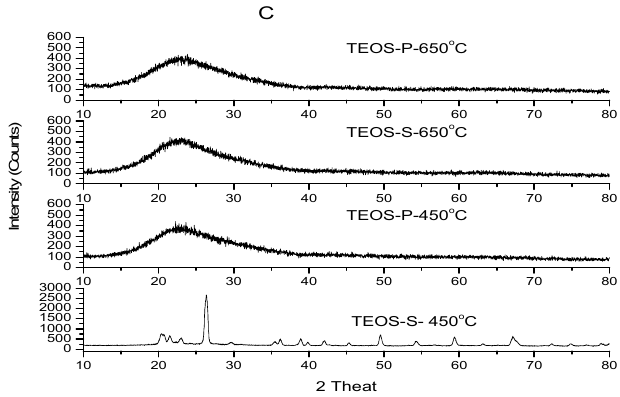
Figure 1. X-ray diffraction patterns of ( A ) SiO 2 and its treatment with sulfuric and phosphoric acid; ( B ) TiO 2 and its treatment with sulfuric and phosphoric acid; and ( C ) SiO 2 obtained by hydrolysis of TEOS treated with sulfuric and phosphoric acid calcined at 450 and 650 °C.